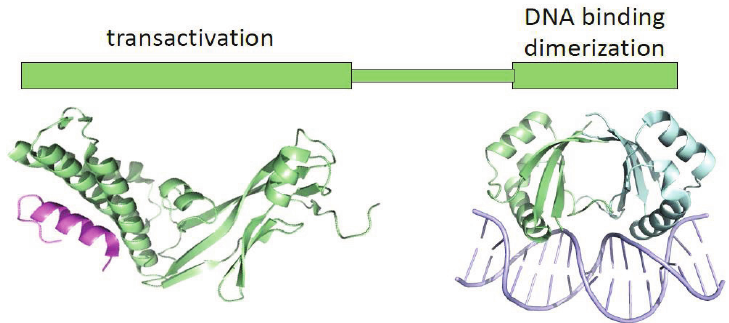
Figure 2. Structure of the papillomavirus E2 protein. The two domains of the E2 protein are shown. The transactivation domain structure is of HPV16 E2 bound to the Brd4 C-terminal motif (CTM). The Brd4 C-terminal peptide (residues 1343 – 1362) is shown in magenta. This structure is from the pdb file, 2NNU. The DNA binding domain is of the HPV18 DNA binding domain bound to DNA (shown in light purple) from the pdb file